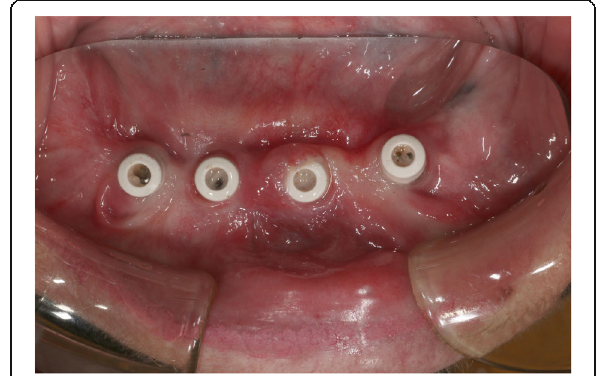
Fig. 5 Resolution of gingival enlargement around healing abutments